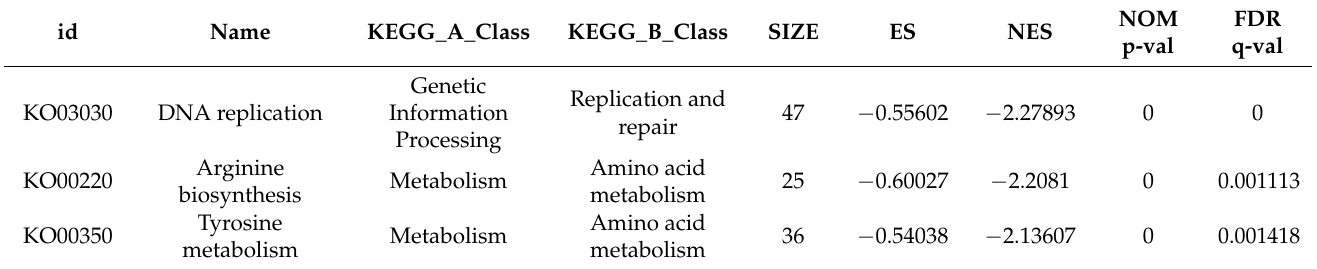
Figure 7. The Gene ontology (GO) enrichment analysis of differentially expressed genes (DEGs) in FM vs. R64 ( A ), and KEGG pathways of differentially expressed genes (DEGs) in FM vs. R64 ( B ). Table 6. Fifteen KEGG-enriched pathways significantly downregulated in gene set enrichment analysis